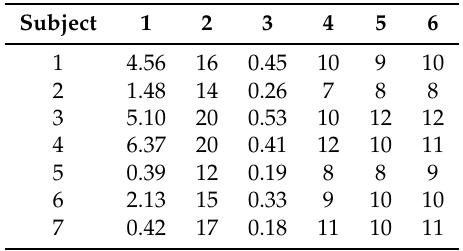
Table 2. Performance obtained by healthy subjects measured in